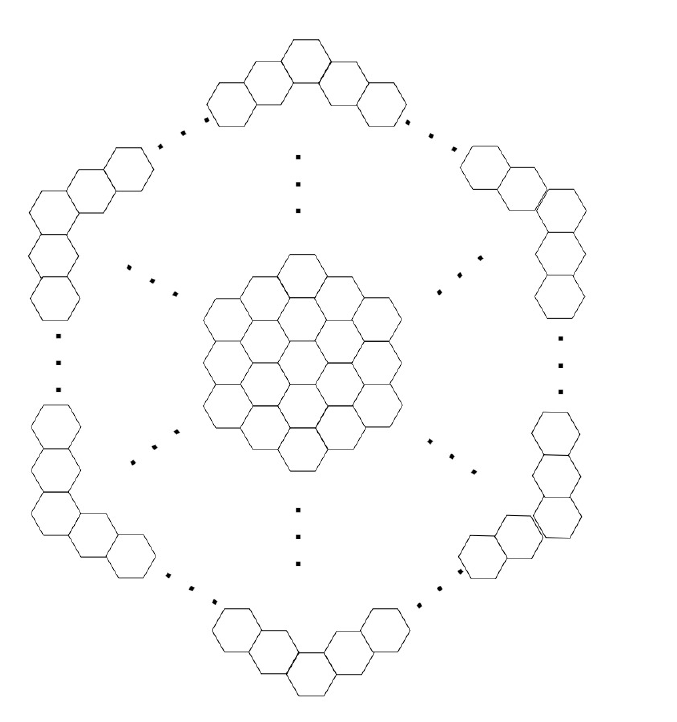
Figure 12. The circumcoronene series of benzenoid H k for k ≥